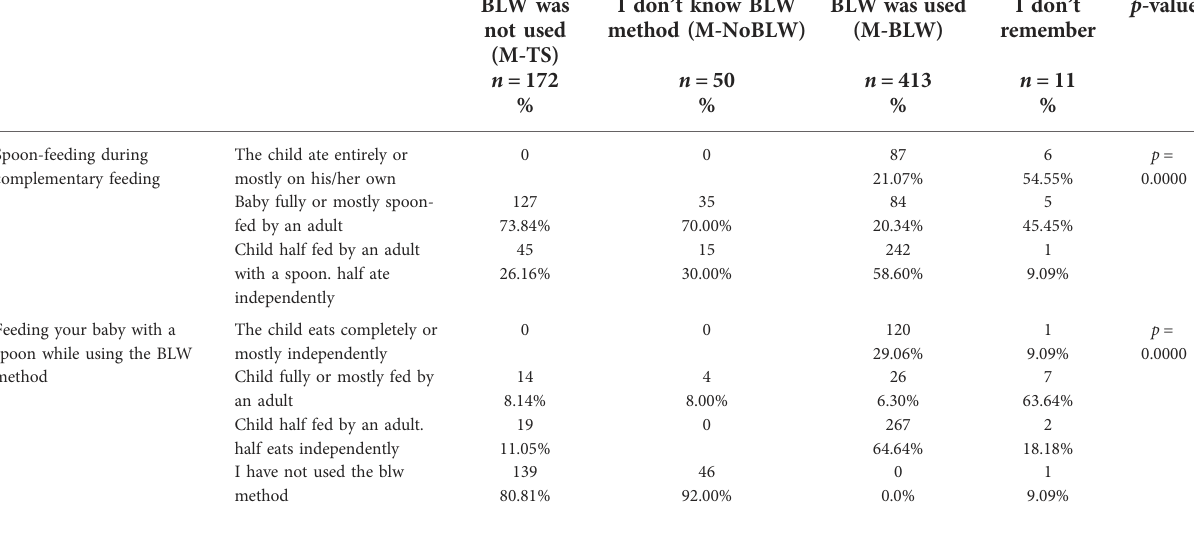
TABLE 6 Feeding the child with a spoon during complementary feeding and when using the BLW method ( N